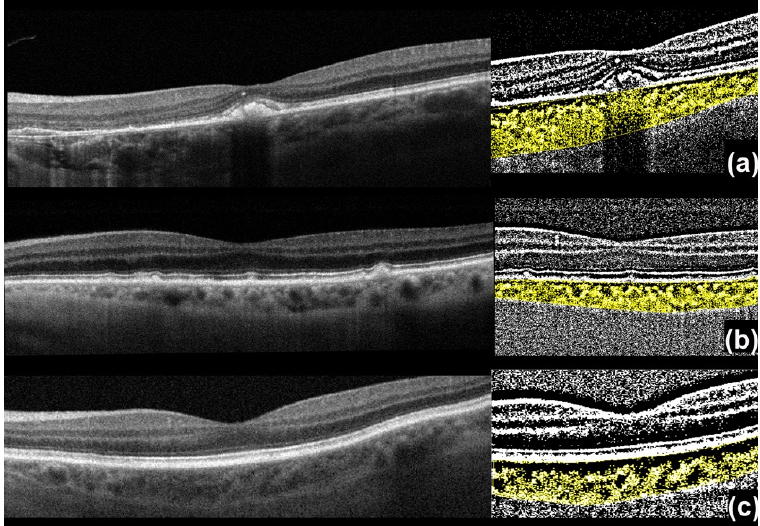
Figure 3. Choroidal vascularity index performed in the three subgroups considered. ( a ) Adult-onset foveomacular vitelliform dystrophy; ( b ) early age-related macular degeneration with conventional drusen; ( c ) age-matched healthy control.